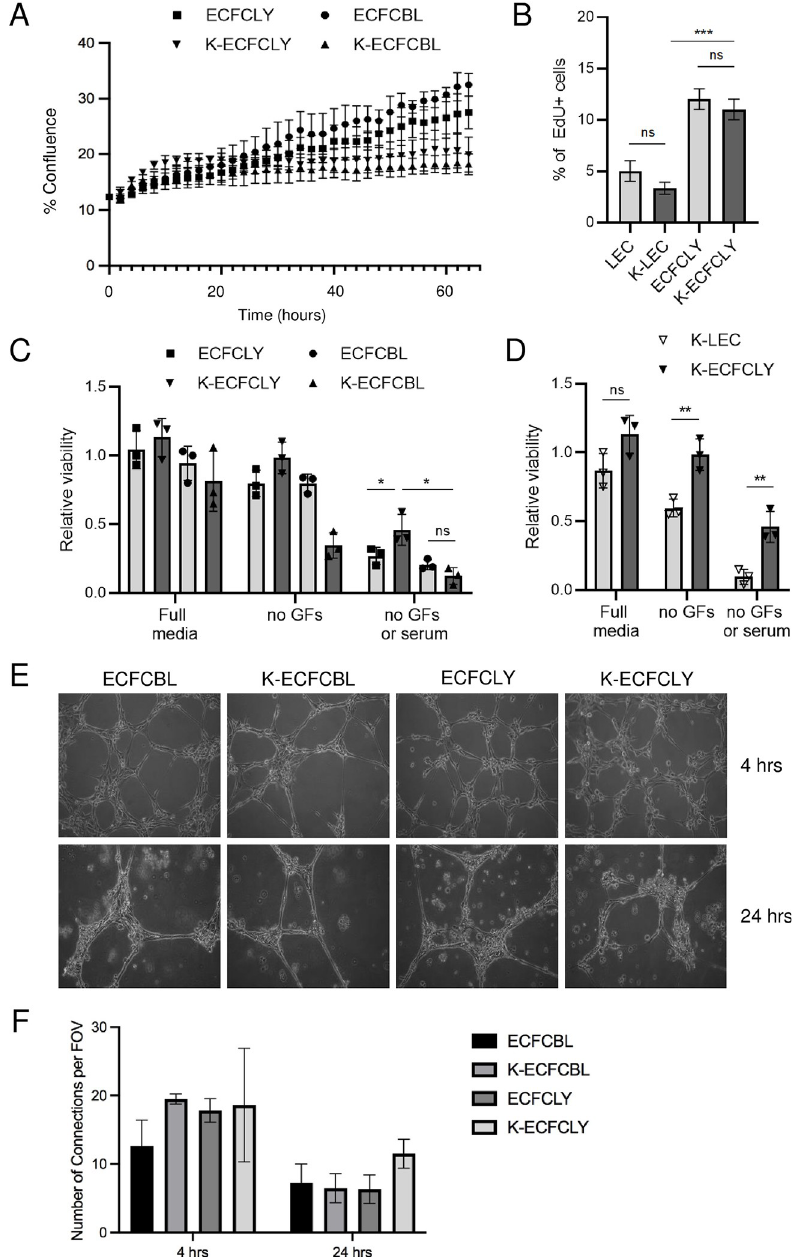
Fig 2. KSHV inhibits proliferation but not capillary morphogenesis. A. 48 hours after infection with KSHV, ECFCLY (squares), ECFCBL (circles), K-ECFCLY (upside down triangles) and K-ECFCBL (triangles), were seeded in 6-well dishes and placed in an Essen Biosciences IncuCyte. Pictures were taken every two hours and the percentage of confluence was determined. B. Mock- or KSHV-infected ECFCLYs or LECs were seeded 5 d.p.i on 96-well dishes and treated with EdU for 4h before fixing. EdU-positive cells were stained, and percentages of proliferating cells were determined. C. Indicated cell types mock or KSHV-infected as in B were grown for seven days in full or serum and/or growth factor deprived media and measured for relative viability by a CellTiter-Glo luminescence assay. D. Relative viability of K-LECs and K-ECFCLYs grown and analyzed as in C. E. Blood and lymphatic ECFCs were mock- or wtKSHV-infected. 48 h.p.i cells were plated on Matrigel and monitored for capillary morphogenesis at 4 and 24 hours post plating and F. number of branches per field was quantified. � p < 0.05, �� p < 0.01, ��� p < 0.001.